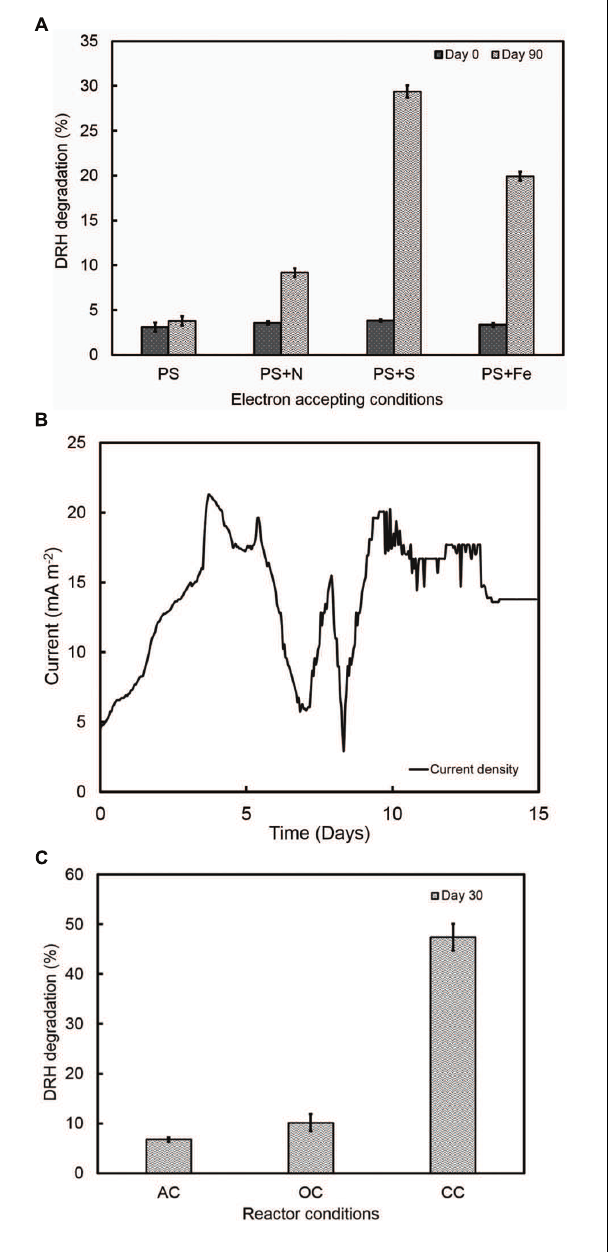
FIGURE 6 | (A) Photoorganotrophic hydrocarbon degradation under different electron accepting conditions (PS-photosynthetic; PS + N- Photosynthetic + Nitrate; PS + S; Photosynthetic + Sulfate; PS + Fe- Photosynthetic + Iron). (B) A representative current density cycle of diesel fed microbial fuel cell system using strain RP2. (C) Hydrocarbon degradation under different reactor operating conditions (AC, Abiotic controls; OC, Open circuit controls; CC- Closed